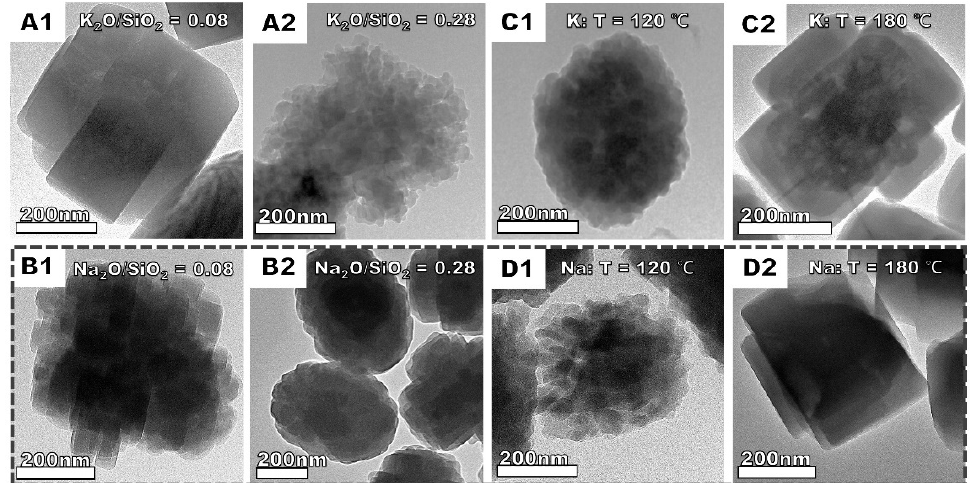
Figure 2. The TEM images of the products synthesized in the K + system with M 2 O/SiO 2 = ( A1 ) 0.08, ( A2 ) 0.28; the Na+ system with M2O/SiO2 = ( B1 ) 0.08, ( B2 ) 0.28; the K+ system at hydrothermal temperature of ( C1 ) 120 °C, ( C2 ) 180 °C; and the Na+ system at hydrothermal temperature of ( D1 ) 120 °C, ( D2 ) 180 °C.